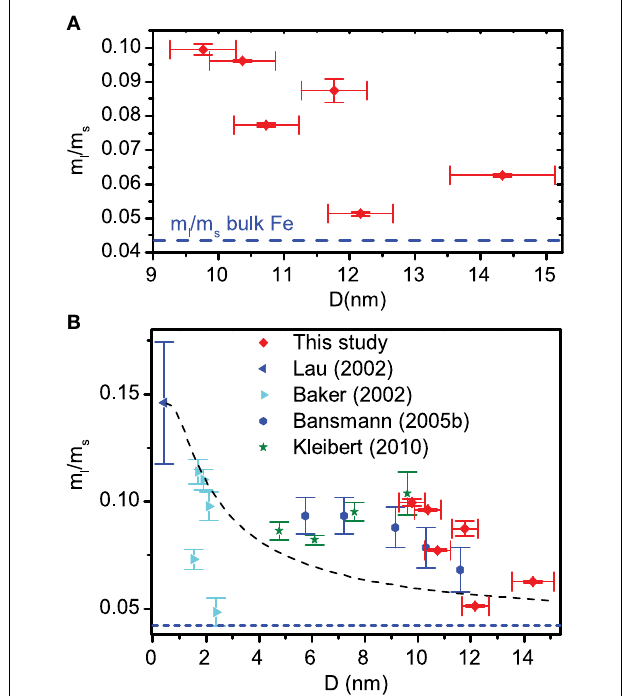
FIGURE 3 | (A) m l / m s ratio plotted against scaled mean particle diameter as found by AFM. The bulk Fe m l / m s ratio is shown as a blue dashed line. In (B) the results of our study are combined with data from previous studies [ 25, 28–30]. The black dashed line is a fit using the model described in the